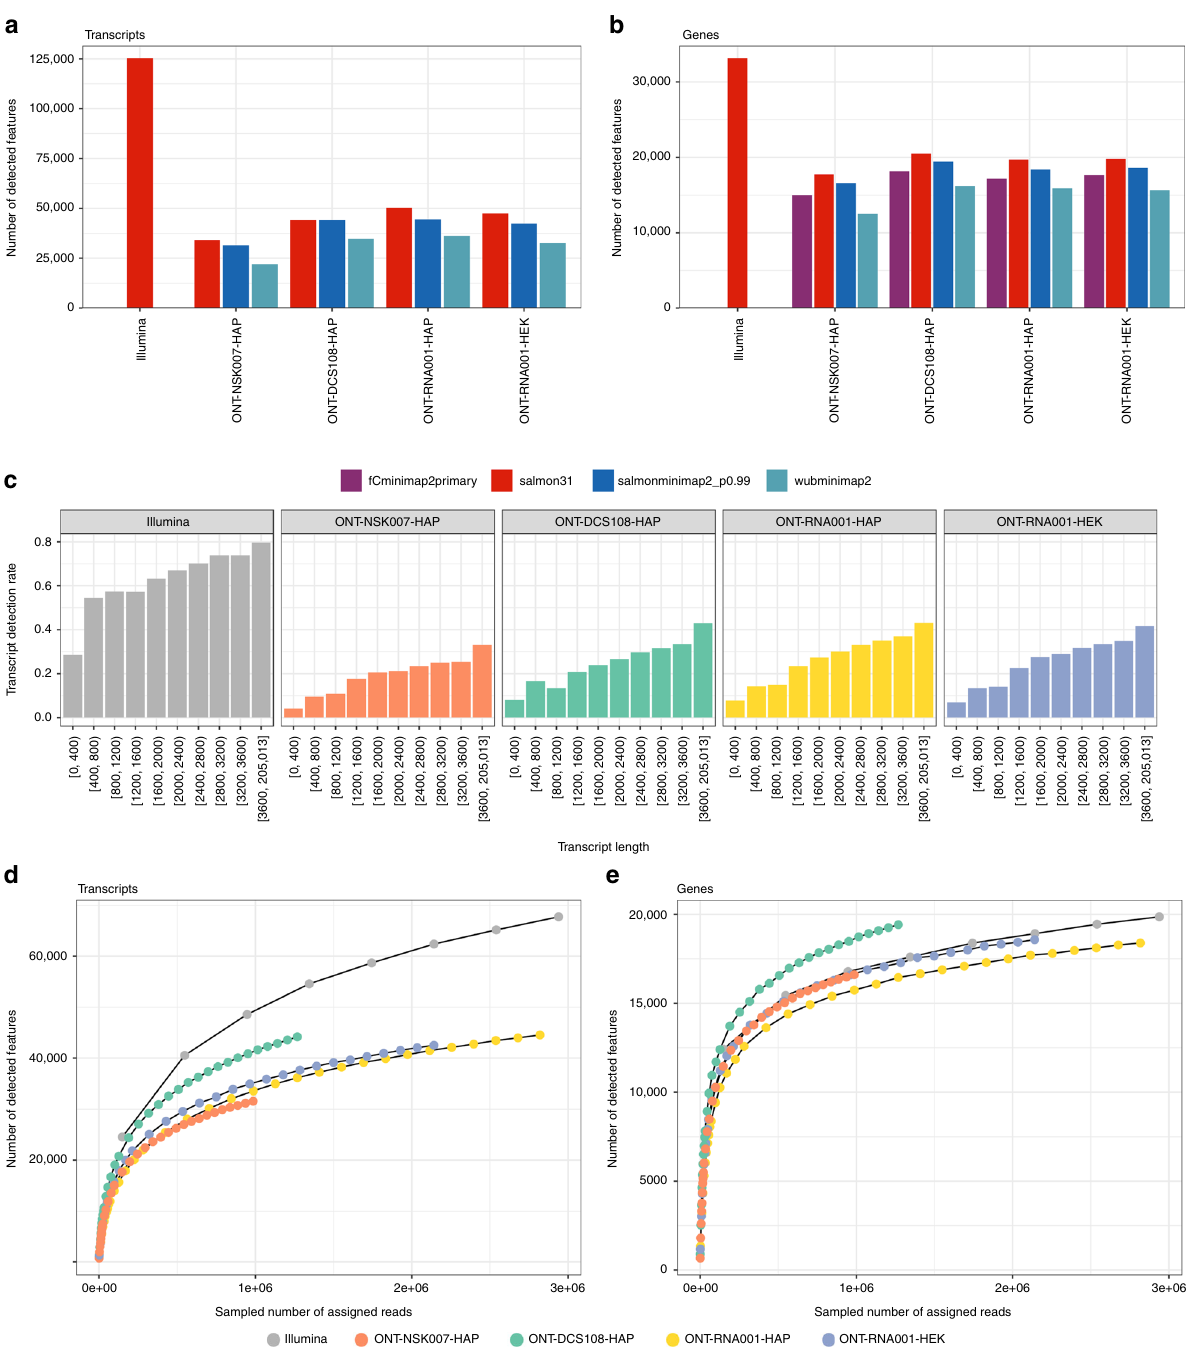
Fig. 4 Detection of annotated transcripts and genes. a , b Number of detected transcripts and genes with the applied abundance estimation methods. Here, a feature is considered detected if the estimated read count is ≥ 1. c Fraction of transcripts detected (with estimated count ≥ 1), strati fi ed by transcript length, in the respective data sets. d , e Saturation of transcript and gene detection in ONT and Illumina data sets. For each data set, we aggregated reads across all replicates, subsampled the reads and recorded the number of transcripts and genes detected with an estimated salmonminimap2 count (ONT libraries) or Salmon count (Illumina libraries) ≥ 1. The Illumina curves are truncated to the range of read numbers observed in the ONT data sets. Source data are provided as a Source Data fi